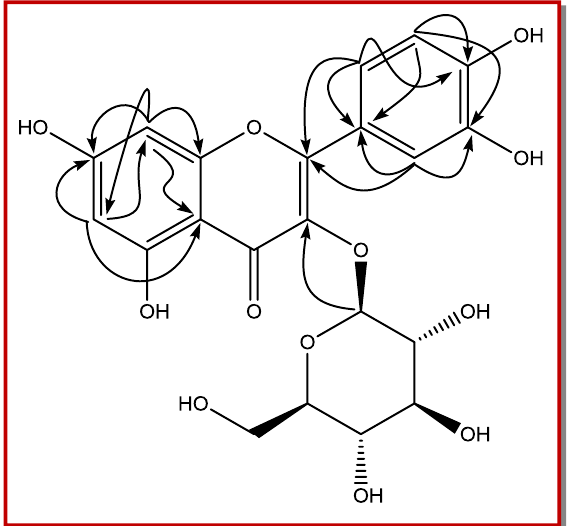
Figure 3: Key COSY and HMBC structure of